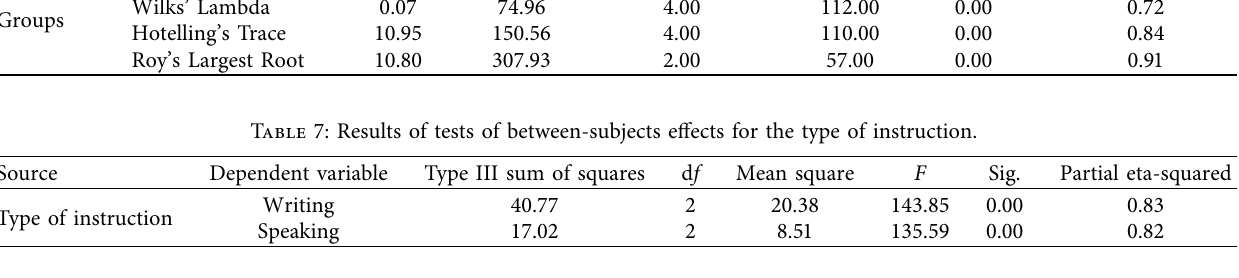
Table 8: Results of post hoc test for the type of instruction.